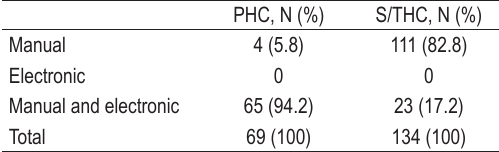
TABLE 2 . A manner of completing nursing documentation